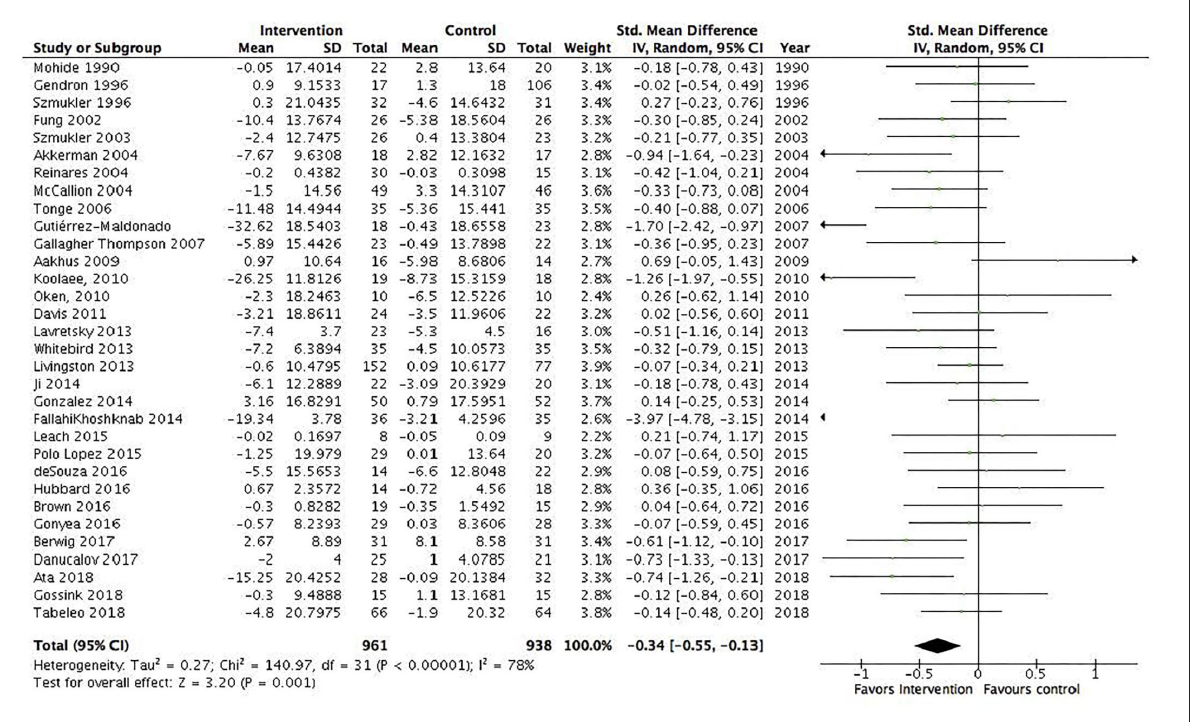
FIGURE2 All informal caregiver interventions included in the meta-analysis. Mean within-group changes and standardized mean differences.